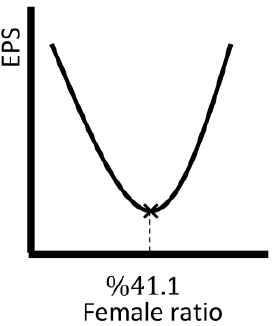
Figure 2. The critical female ratio in the full sample with respect to ROA.